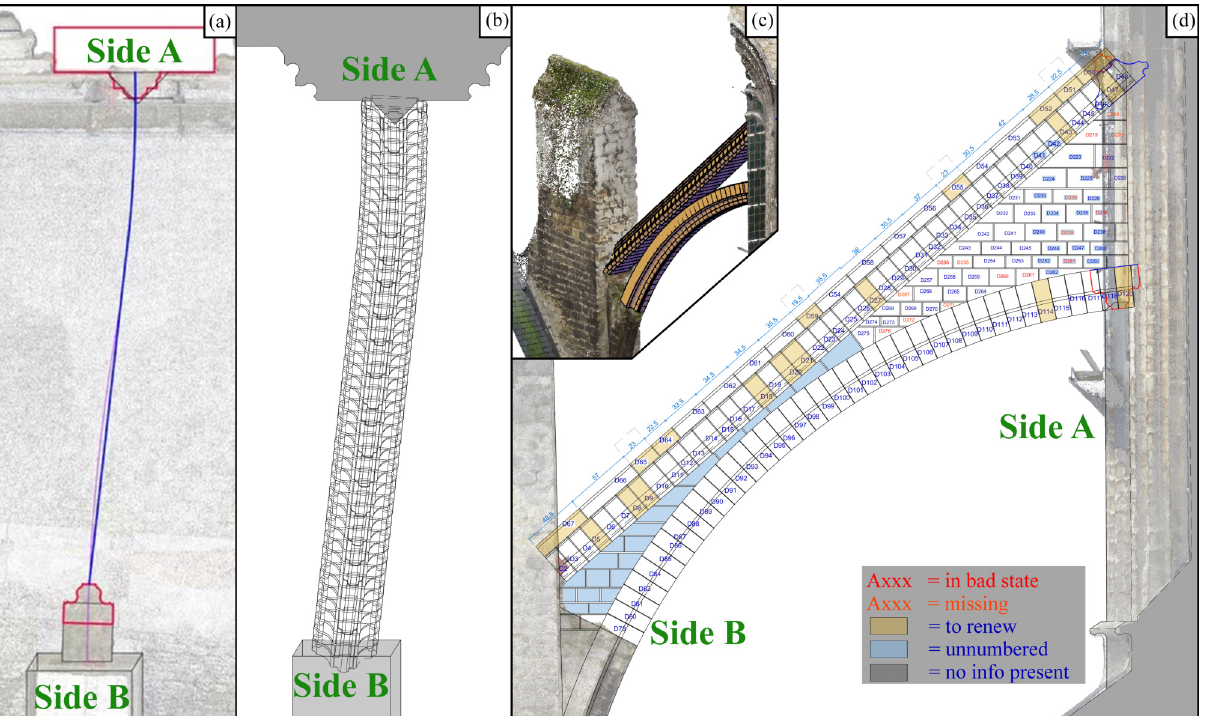
Figure 4: Top-view orthophoto depicting the displacements of one of the flying buttresses. The horizontal displacement in the Y- direction is 34,8cm. The two bases are also rotated for 1,37 degrees relative to each other.